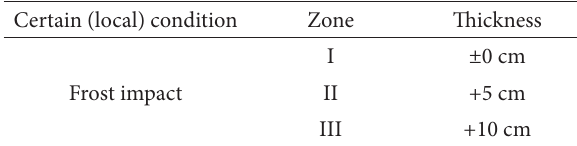
Fig. 7. Map of frost impact Table. Correction of the thickness of road pavement